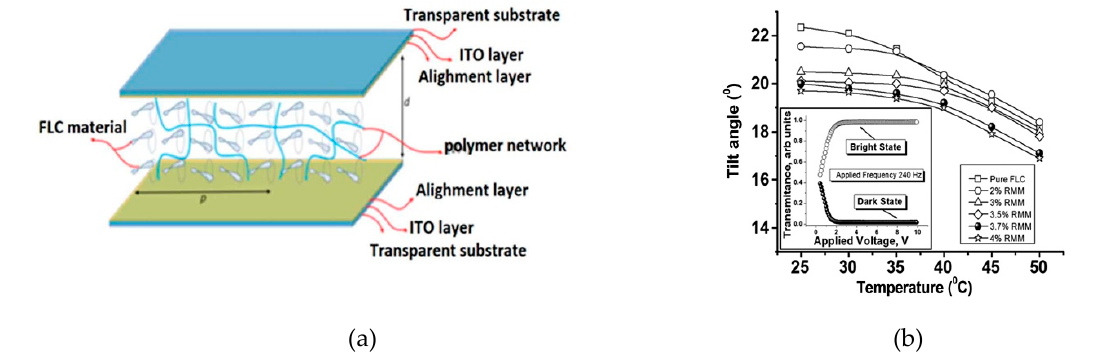
Figure 4. ( a ) Schematic representation of the ESHFLC cell, where p is the helix pitch of the FLC and d is the cell gap. ( b ) Temperature dependence of the tilt angle θ for pure FLC and polymer-stabilized FLC mixtures. The inset shows the plot of the transmittance in the bright and dark states versus the driving voltage for FLC polymer mixture of the 3.5% wt / wt monomer.